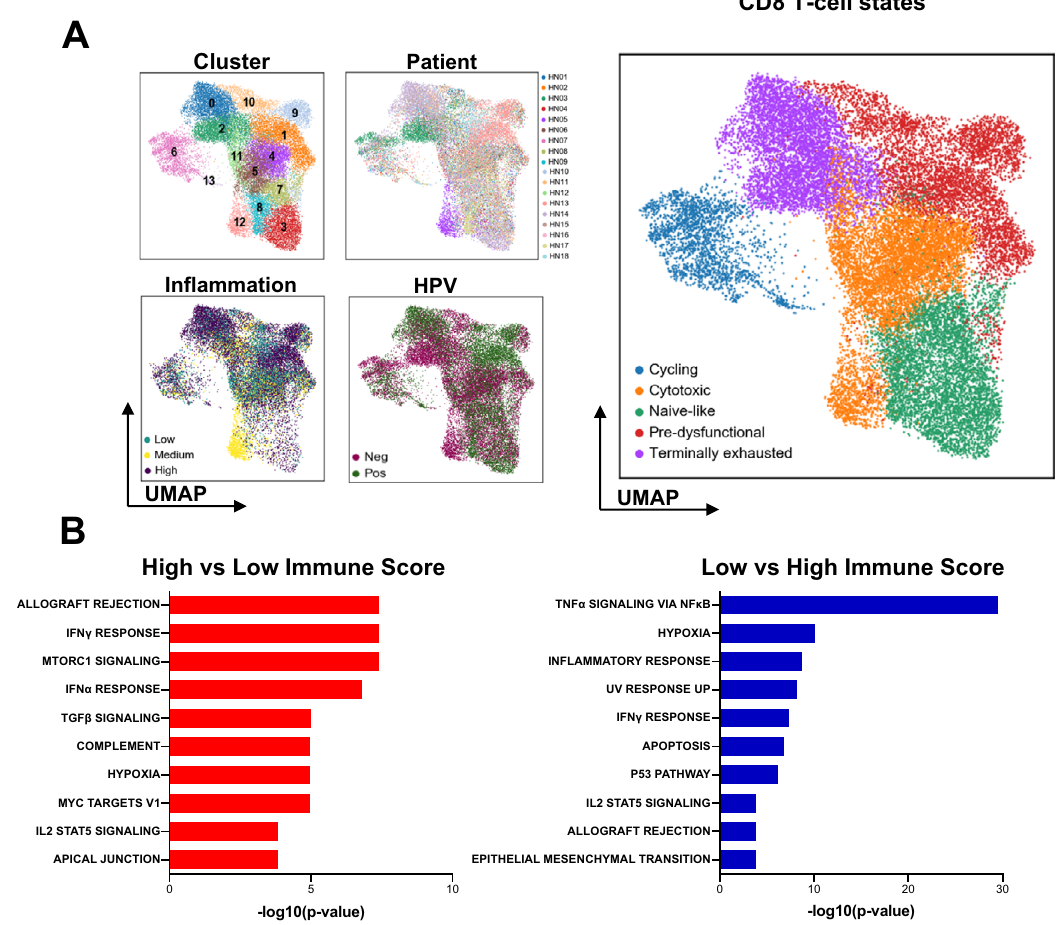
Fig. 2 Detailed characterization of CD8 + T cells and intratumoral CD8 + cell differences in tumors with low and high in fl ammation scores. A Sub- clustering of 27,013 CD8 + T cells ( n = 18 patients; cluster 0 – 13) and visualization of relevant characteristics: patient contribution (HN01 – HN18), viral- status (HPV + vs. HPV – ), in fl ammation score (low, medium, high; cells from the PBL, as well as all cells from HN03 were excluded) and CD8 + T cell sub- states (cycling, cytotoxic, naive-like, pre-dysfunctional, terminally exhausted). B Hallmark gene sets enriched (using the Computer Overlaps tool from MSigDB) in the top 100 DEGs between CD8 + T cells from high vs. low in fl ammation patients (and vice versa, all p < 0.01). p -values for enrichment were extrapolated from hypergeometric